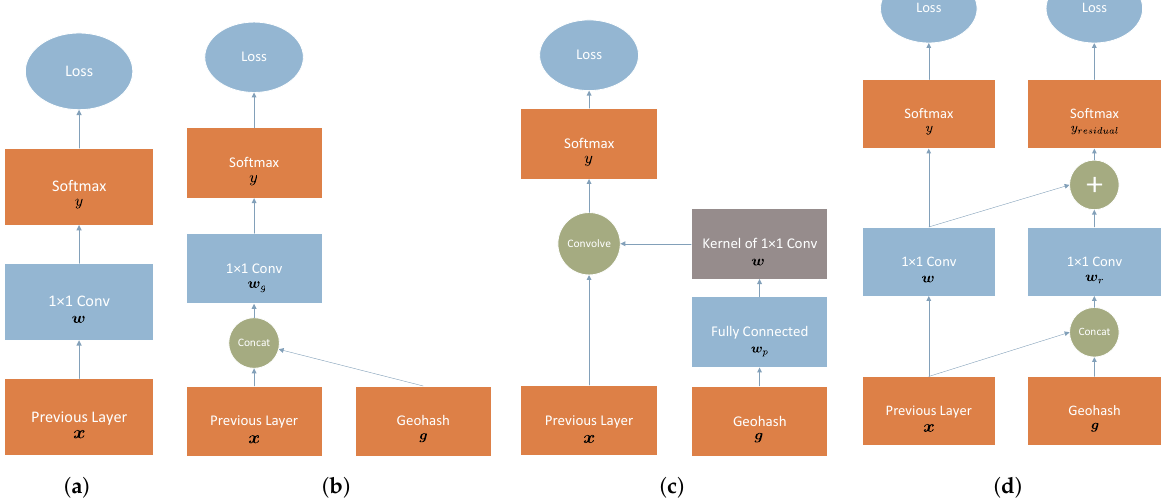
Figure 5. Different strategies of feeding the binary geohash into neural networks: ( a ) a typical form of layers for semantic segmentation; ( b ) adding the binary geohash code to the feature space (concatenation); ( c ) adding the binary geohash code to the parameter space; and ( d ) residual correction of the